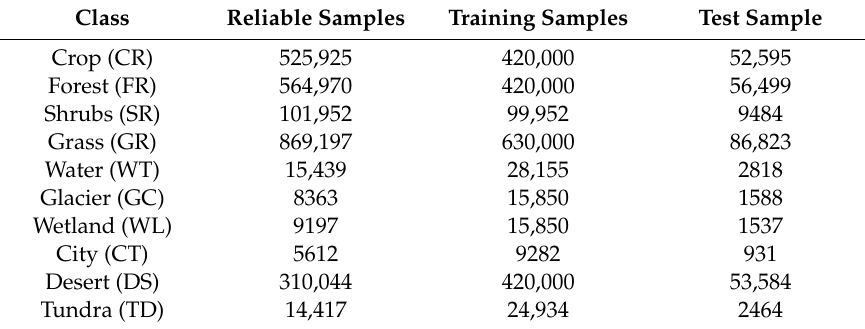
Table 1. Training set and test